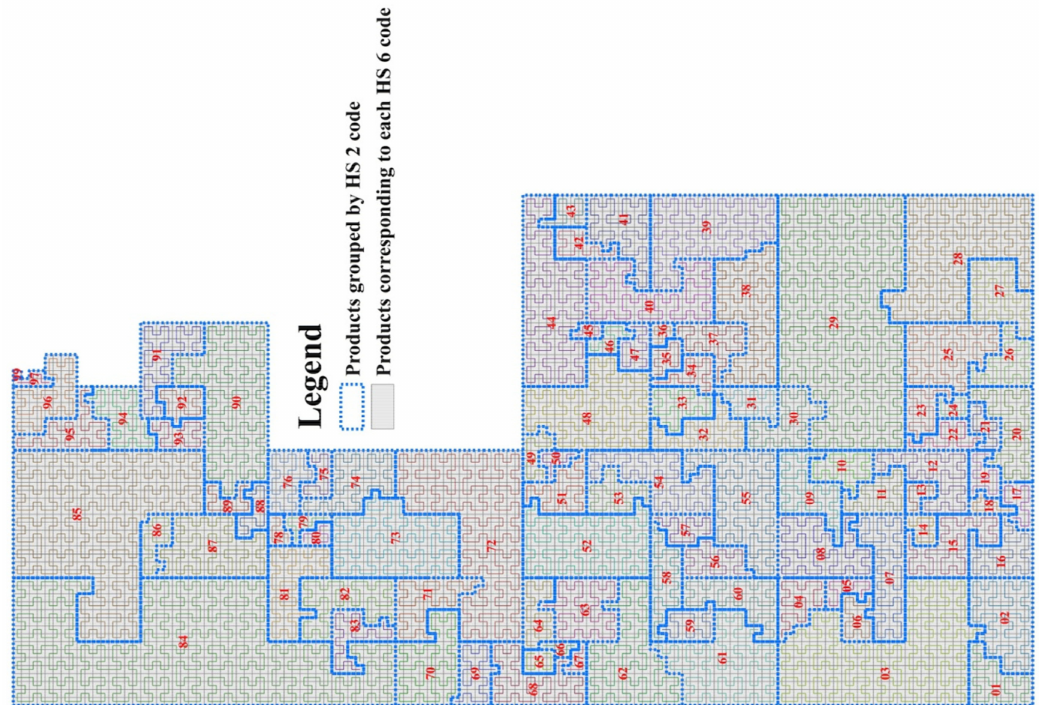
Figure A2. HS 6-digit code grid system (each type of HS 6-digit code product corresponds to one grid, and the marked number is HS 2-digit code of the product category it belongs to).